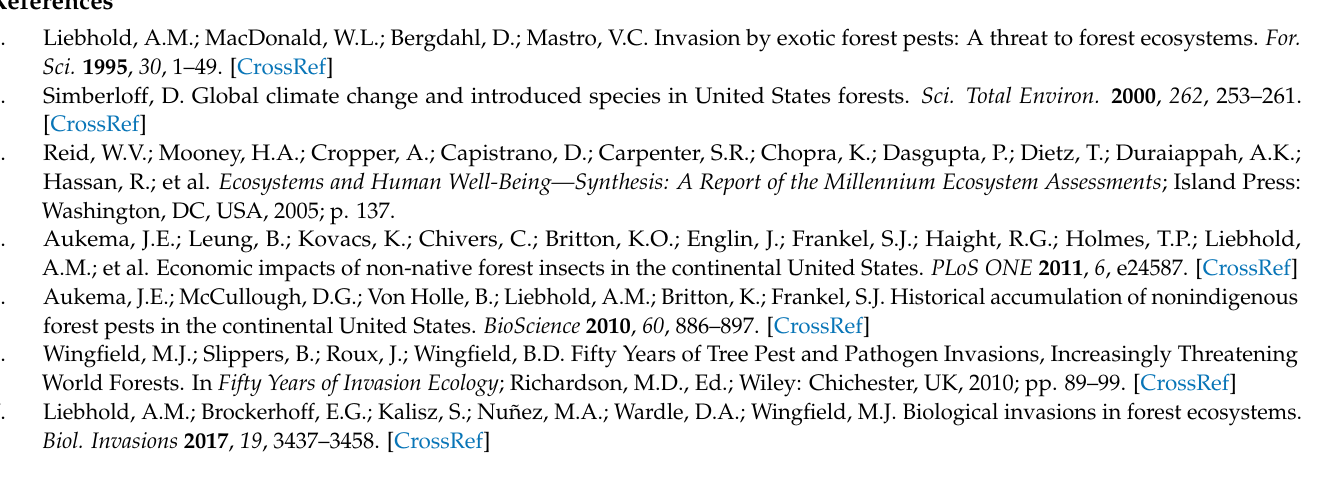
Figure S2: The trend of average annual and seasonal precipitation in the survey locations between 1950 and 2017. Figure S3: The trend of maximum annual and seasonal temperatures in the survey locations between 1950 and 2017. Figure S4: The trend of minimum annual and seasonal temperatures in the survey locations between 1950 and 2017. Figure S5: Romania’s round-wood import dynamics between 1997 and 2016, from the main European partners (data source: FAO,